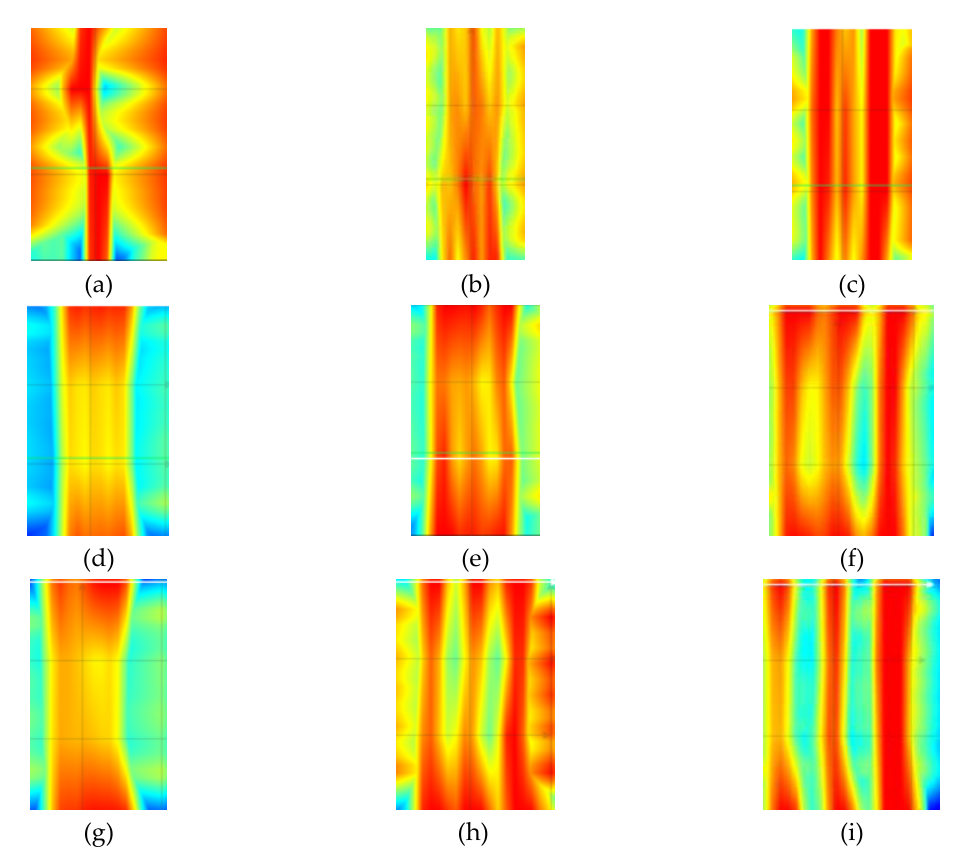
Figure 22. Results from tests performed with the electromagnetic device (2): ( a ) S-10-20 (result: two rebars, ø obs = 14 mm, c obs = 7.8 mm), ( b ) S-10-30 (three rebars, ø obs = 13 mm, c obs = 9.7, mm), ( c ) S-10-40 (three rebars, ø obs = 12 mm, c obs = 9.7 mm), ( d ) S-16-20 (three rebars, ø obs = 17 mm, c obs = 19.5, mm), ( e ) S-16-30 (three rebars, ø obs = 16 mm, c obs = 19.8, mm), ( f ) S-16-40 (three rebars, ø obs = 14 mm, c obs = 21.9, mm), ( g ) S-20-20 (one rebar, ø obs = 20 mm, c obs = 29 mm), ( h ) S-20-30 (three rebars, ø ob = 18 mm, c obs =